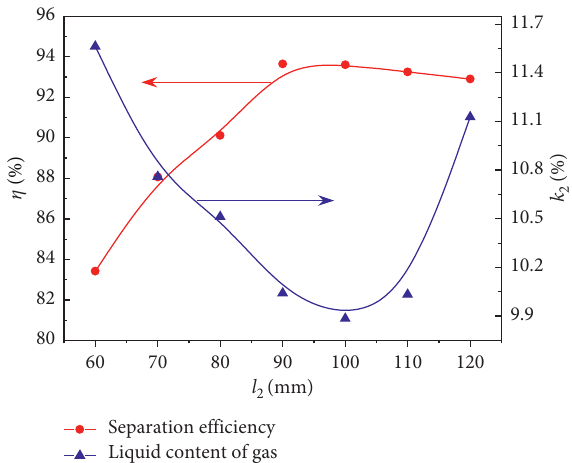
Figure 17: Effect of cylinder lengths on separation efficiency and gas-liquid content.